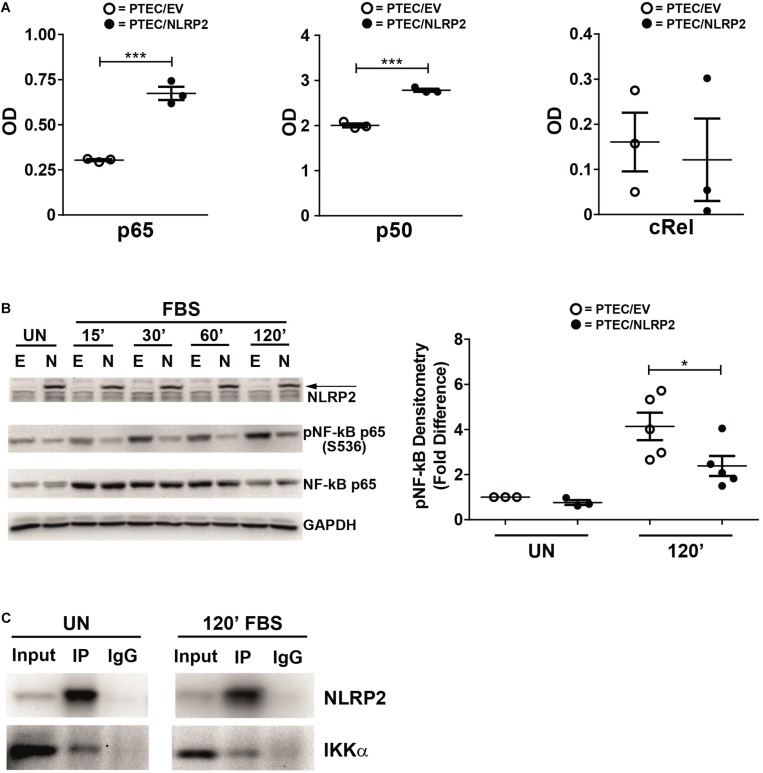
NLRP2 regulates NF-κB DNA-binding activity, reduces NF-κB p65 phosphorylation in Serine 536 and interacts with IKKα. (A) PTEC/EV and PTEC/NLRP2 were cultured for 3 h in media without serum. Cells were lysed and nuclear extracts were assayed with the TransAm NF-κB family kit (Active Motive) to measure the binding of p65, p50 and cRel to their DNA consensus sequences. Data are shown as mean ± SEM of at least three independent experiments. OD = optical density. (B) PTEC/EV (E) and PTEC/NLRP2 (N) were starved for 3 h in media without FBS and lysed (unstimulated, UN) or stimulated with 10% FBS and lysed at the indicated time points (15, 30, 60, and 120 minutes). NLRP2, phosphorylated (S536) NF-κB p65 and total NF-κB p65 protein levels were assessed by Western blot analyses. GAPDH is used as loading control. Densitometric quantification of phosphoNF-κB p65 (S536) protein levels (right graph) is reported. The data represent mean ± SEM from at least three independent experiments. (C) PTEC/NLRP2 were left unstimulated (UN) or were starved for 3 h and then stimulated with 10% FBS for 120 minutes (120′ FBS). Lysates were immunoprecipitated with anti-NLRP2 antibody and proteins were detected as indicated. Input = total cell lysates; IP = samples immunoprecipitated with anti-NLRP2 antibody; IgG = samples immunoprecipitated with control anti-rabbit IgG. Immunoblot data shown are representative of three independent experiments. ∗p < 0.05, ∗∗∗p < 0.001.